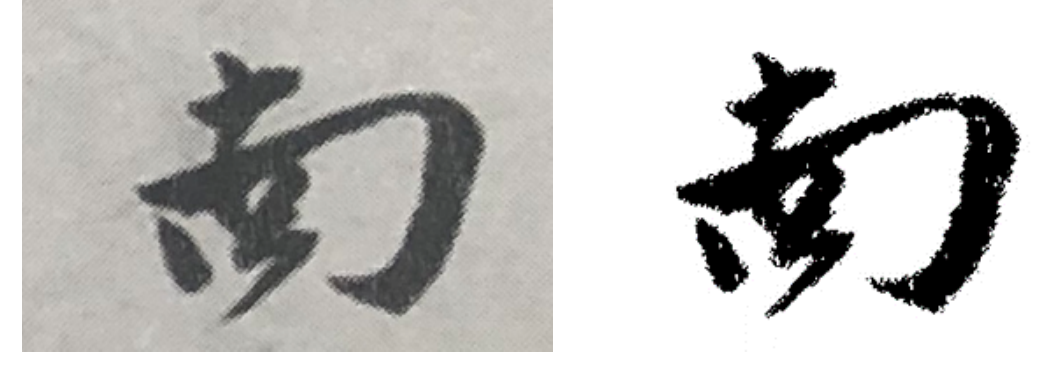
Figure 2. An example of image binarization